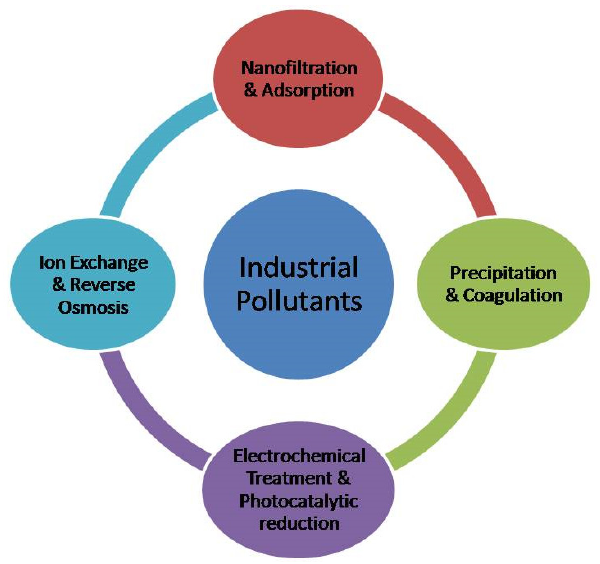
Figure 1. Various available treatment techniques for industrial pollutants.